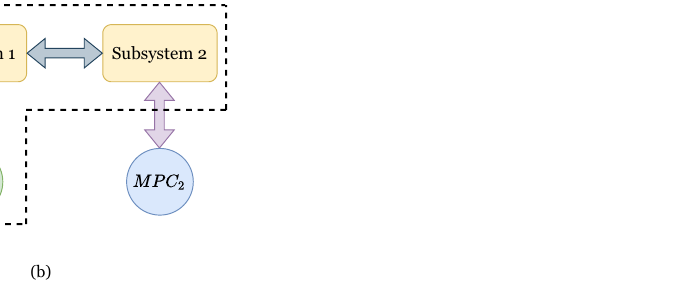
Figure 4. Sequential design of the decentralized MPC controllers: ( a ) MPC 1 for subsystem 1 and ( b ) MPC 2 for subsystem 2 connected to subsystem 1 and MPC 1 in a closed-loop.